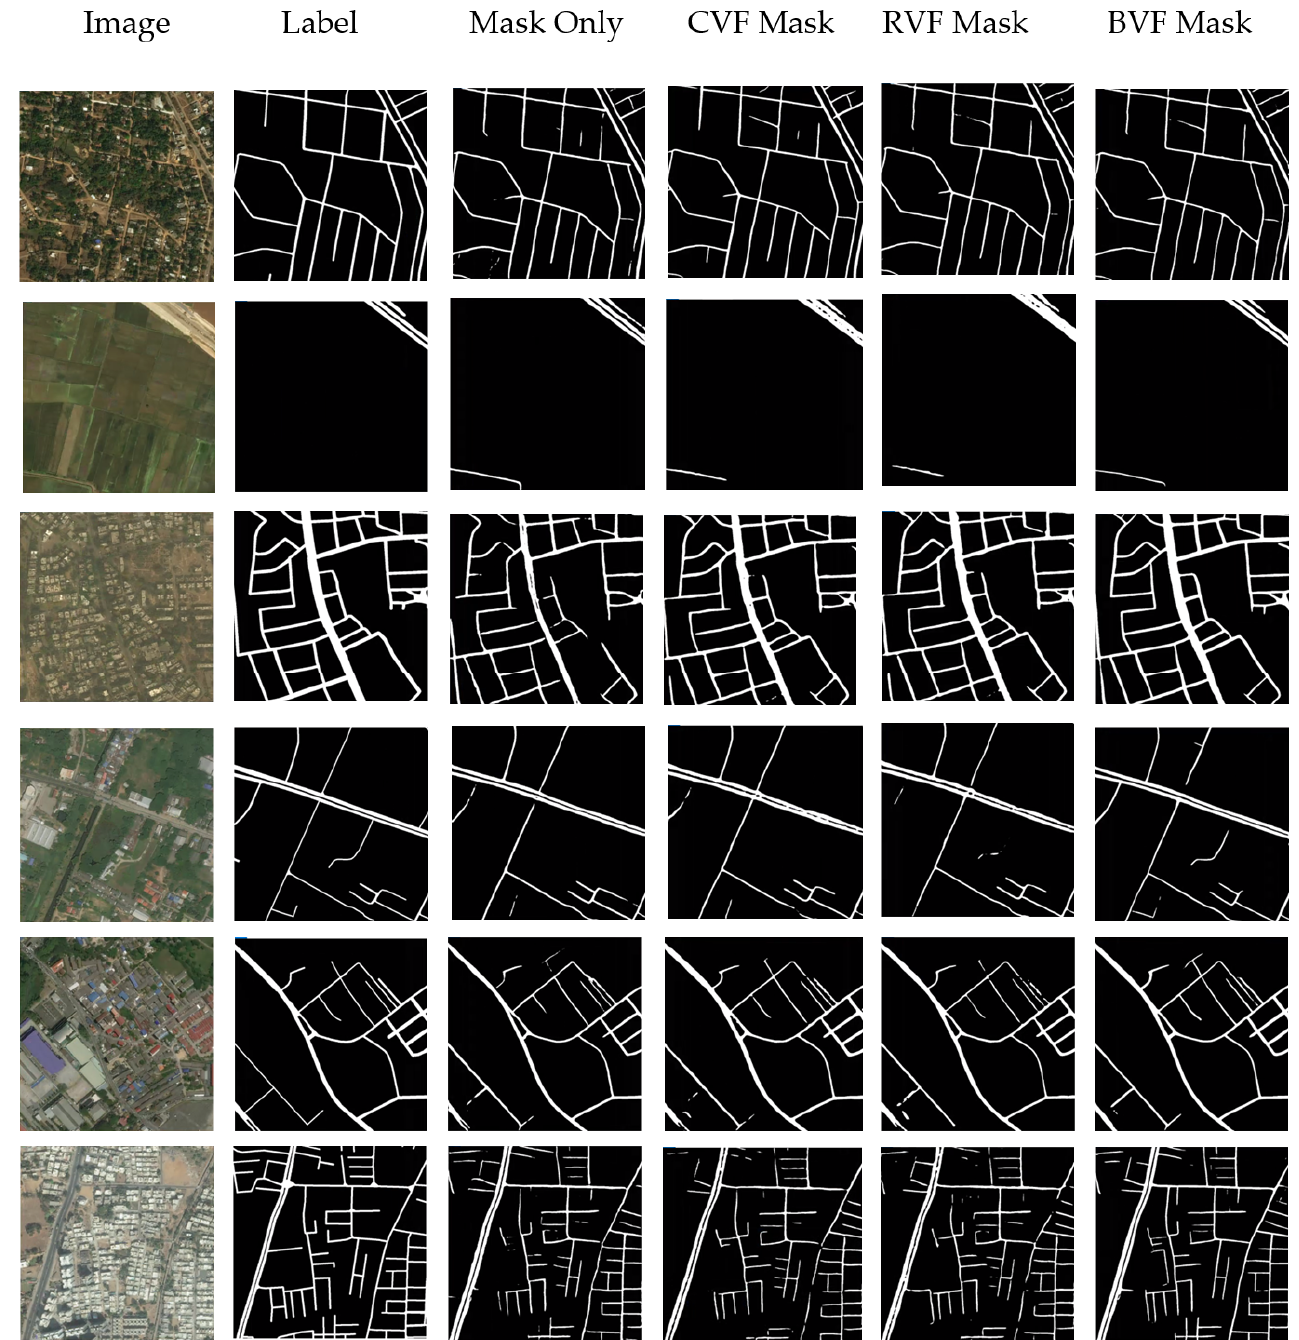
Figure 10. The comparison of different methods. The threshold segmentation of image is carried out.